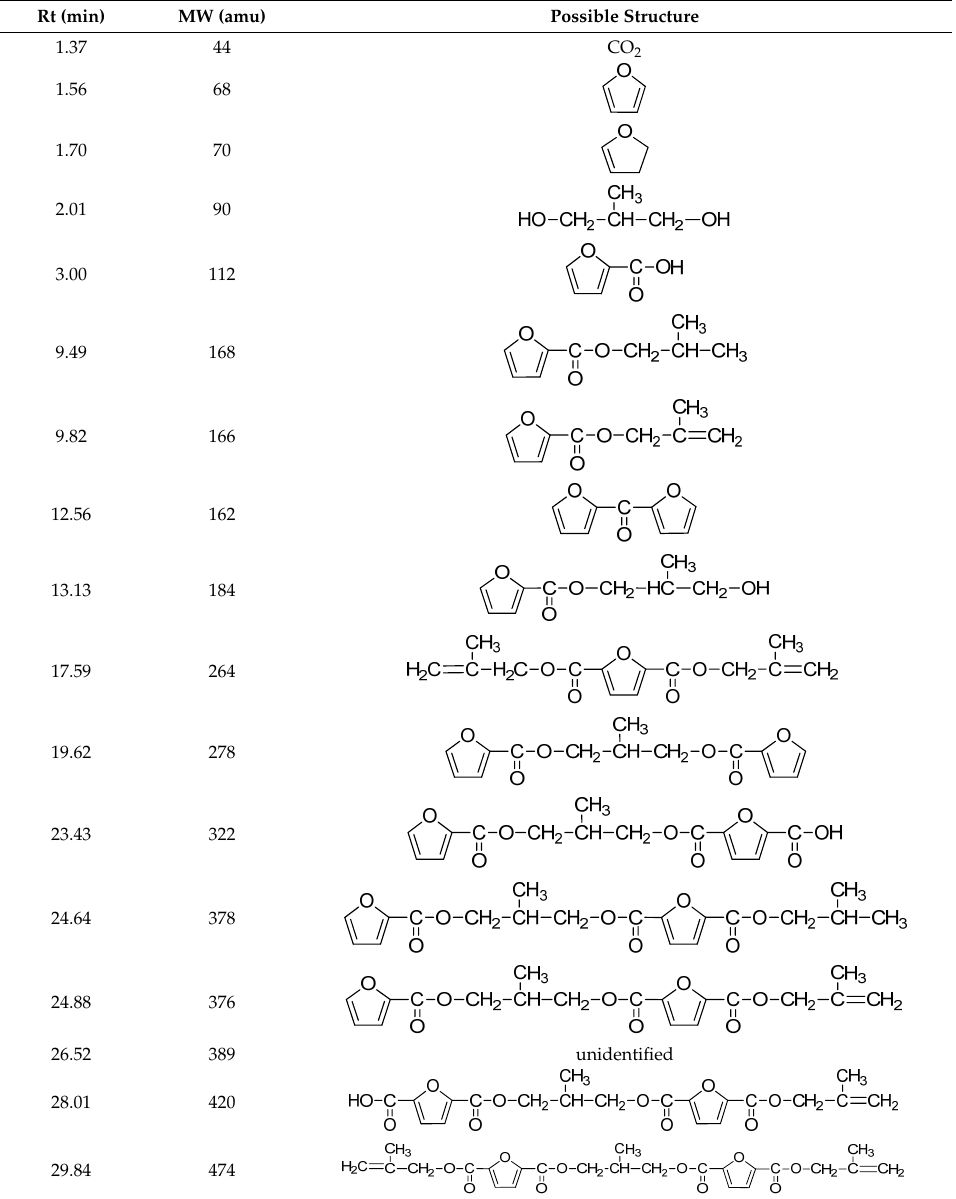
Table 3. Identified pyrolysis products of PMePF.